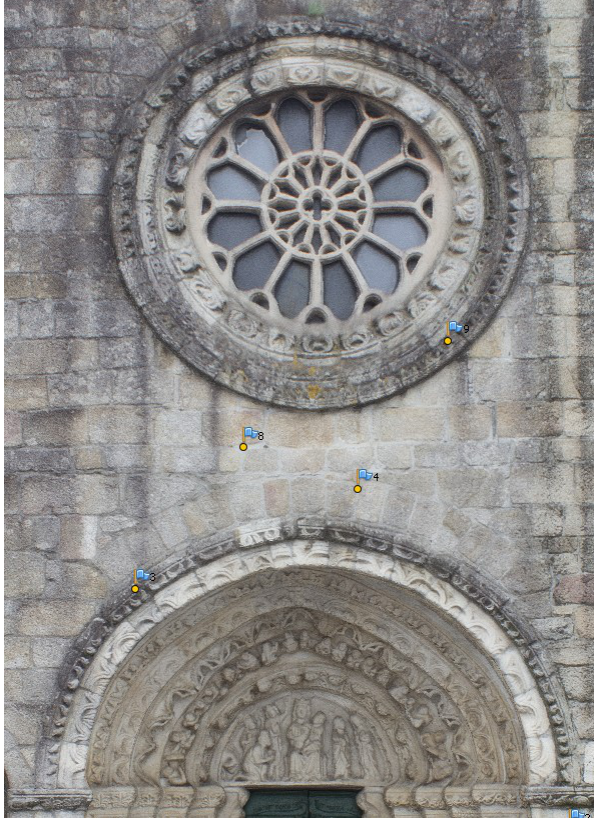
At the end of the modelling process, the projection of the images on the Dense Surface Model was done. Having obtained a Mesh with a triangle size small enough on the face made by the DSM of each triangle, the software projects the image more orthogonal to each triangular face, so the smaller triangles and the more photos available, the better.